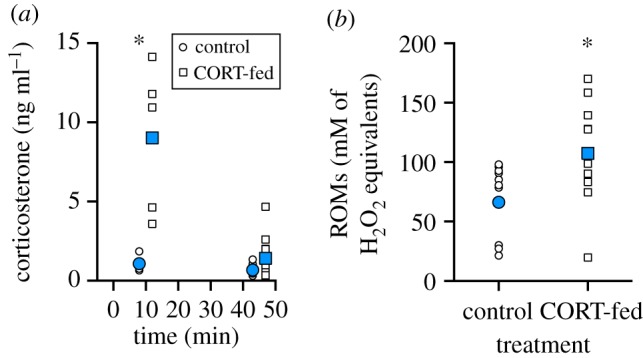
The ingestion of sesame oil (control) or corticosterone in sesame oil (corticosterone-fed) on (a) plasma corticosterone levels at 10 and 45 min post-ingestion, and (b) reactive oxygen metabolites at 45 min post-ingestion. Scatter plots are shown with points jittered to display individual variation and group means are denoted by larger blue symbols and lines. An asterisk denotes statistically significant difference among groups (p < 0.05). For more statistical information, see table 2 and the results. (Online version in colour.)